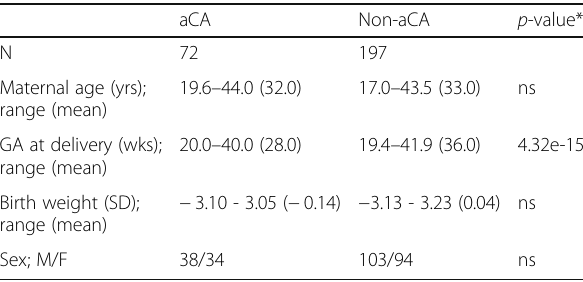
Table 1 Identification of variables confounded with acute chorioamnionitis status